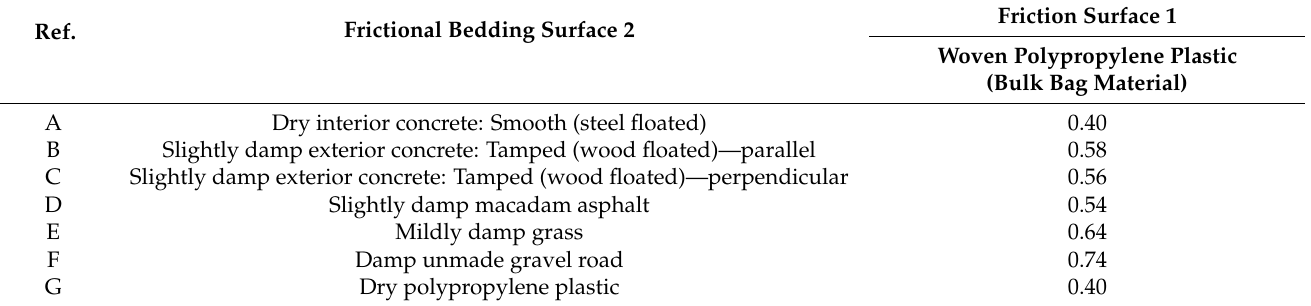
Table 7. Summary of recommended coefficients of static friction ( µ